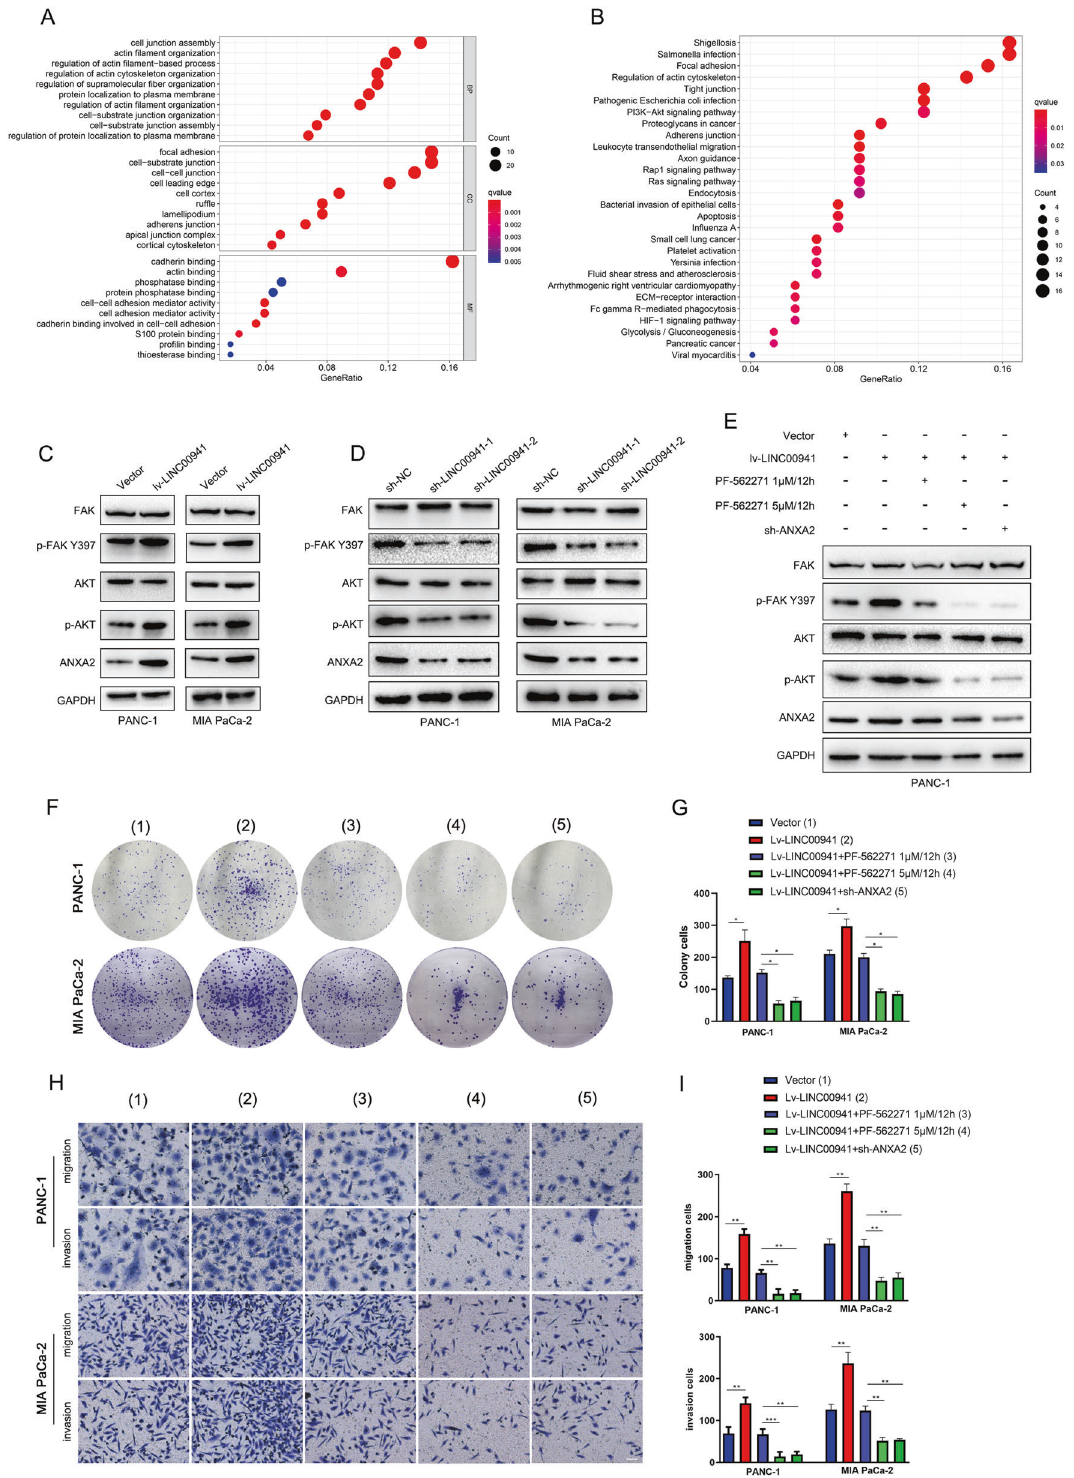
Fig. 6 ANXA2 activates FAK/AKT signaling promoting proliferation, migration, and invasion. A , B Gene Ontology (GO) and Kyoto Encyclopedia of Genes and Genomes (KEGG) analysis based on TCGA data to predict the potential function and involved signaling pathway of ANXA2 by using R software. C The protein expressions of FAK, p-FAK, AKT, p-AKT, and ANXA2 in the empty vector group and LINC00941 overexpression group were measured by western blot analysis. D The protein expressions of FAK, p-FAK, AKT, p-AKT, and ANXA2 in the negative control group and LINC00941 knockdown group were measured by western blot analysis. E Western blot was used for analyzing the protein expressions of FAK, p-FAK, AKT, p-AKT, and ANXA2 in empty vecotr group, lv-LINC00941 group, lv-LINC00941 combining PF-562271 (an inhibitor of FAK pathway) group and lv-LINC00941 + sh-ANXA2 group, respectively. F – I Colony-formation assay and transwell assay were performed to proliferation, migration, and invasion abilities in the empty vector group, lv-LINC00941 group, lv-LINC00941 + PF-562271 group and lv-LINC00941 + sh-ANXA2 group. *, **, and ***, respectively, represent P < 0.05, P < 0.01, and P < 0.001. Cell Death and Disease (2022)